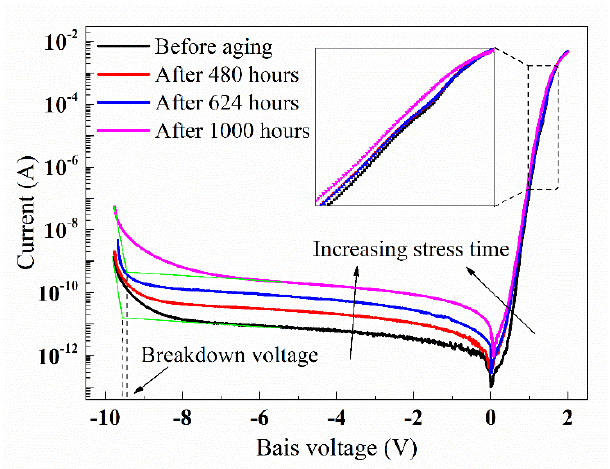
Figure 4. The forward and reverse current – voltage curves of VCSELs, before and after aging.